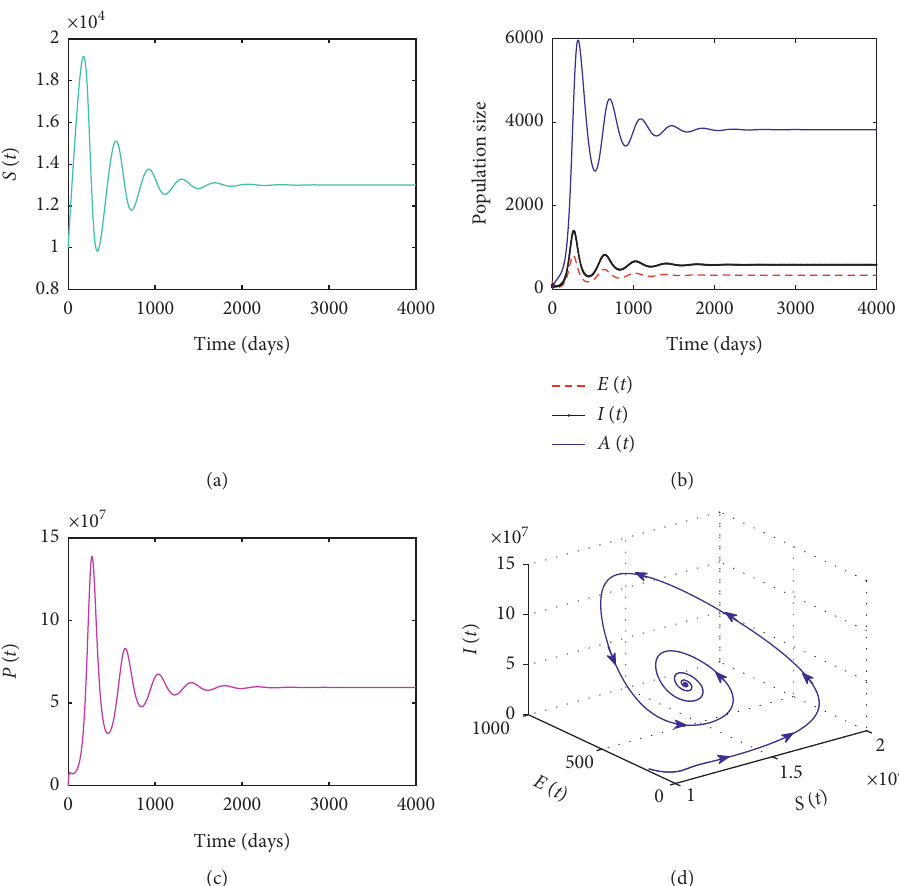
Figure 1: Numerical results of system (1) depicting the persistence of the disease of R Parameter values used to construct the simulations are in Table 1, with p � 0 . 01 and κ � ϵ � 0, leading to R